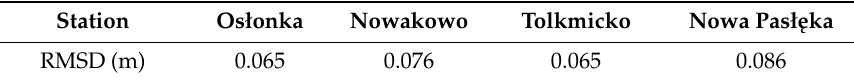
Table 2. Calculated root-mean-square deviation (RMSD) for the calibration period from 6 February to 13 February 2011.